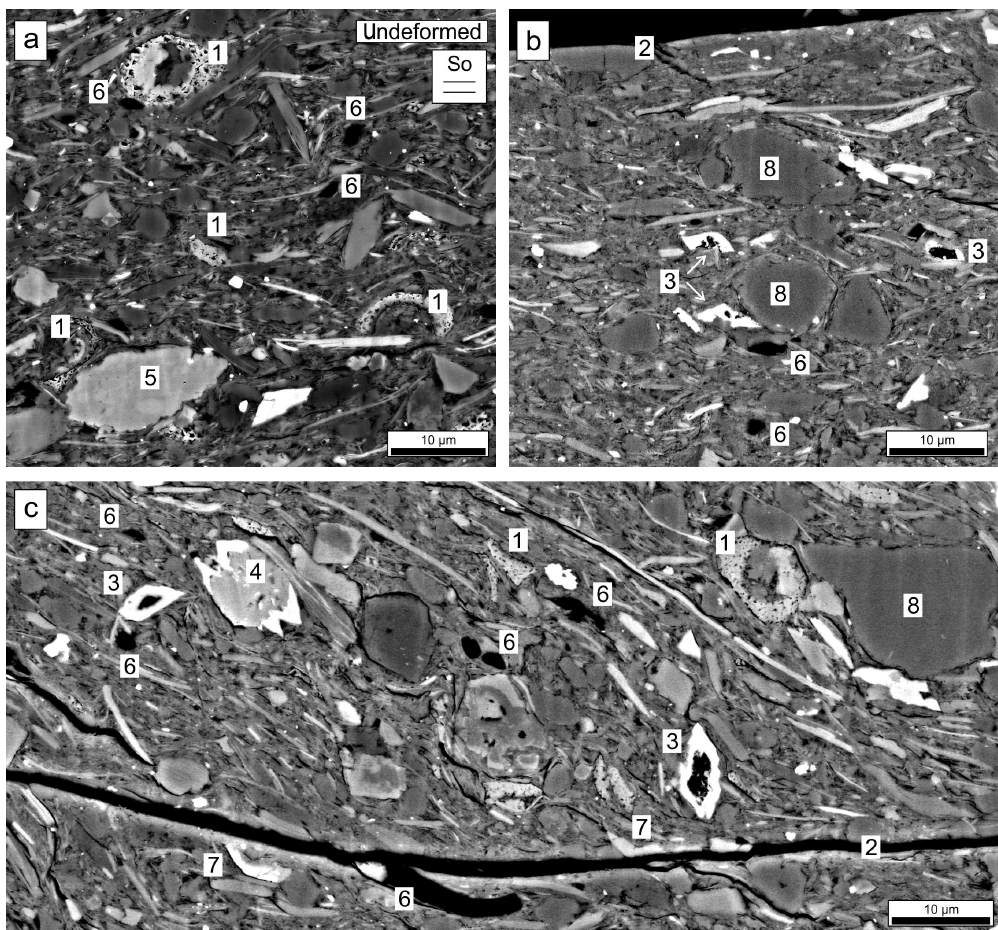
Figure 10. BIB-SEM micrographs comparing an undeformed fabric (a) and microlithon internal fabrics (b) and (c) . (a) derives from the sample shown in Fig. 11a. The locations of (b) and (c) are given in Figs. 8b and 9b, respectively. The images show intact to slightly strained fossils (1), µm-thin shear zones (2), pores in siderites (3), overgrowth (4), a calcite patch (5), dark OM (6), bend particles in the vicinity of a thin shear zone (7) and lobate SiO2 grains (8). Numbering is as in the previous